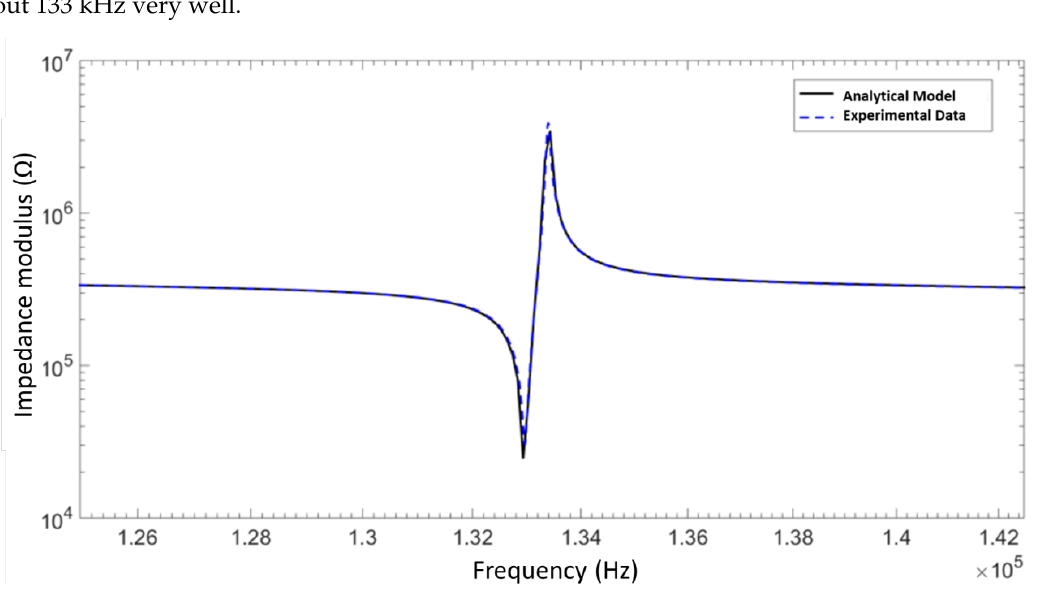
Figure 2. Electrical impedance modulus spectrum in monocrystalline paratellurite about the fundamental face-shear piezoelectric excitation.